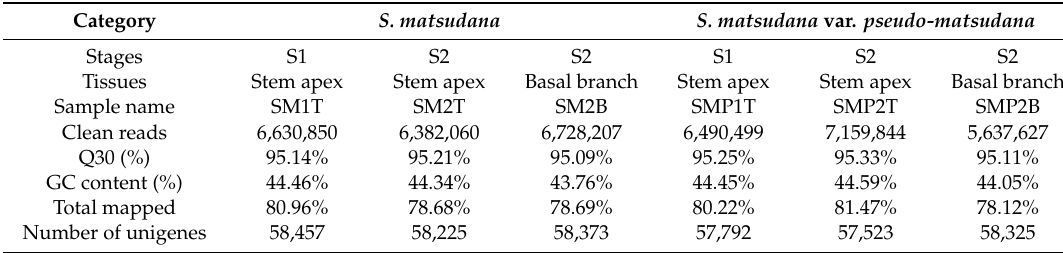
Table 1. Basic characteristics of the six DGE libraries.